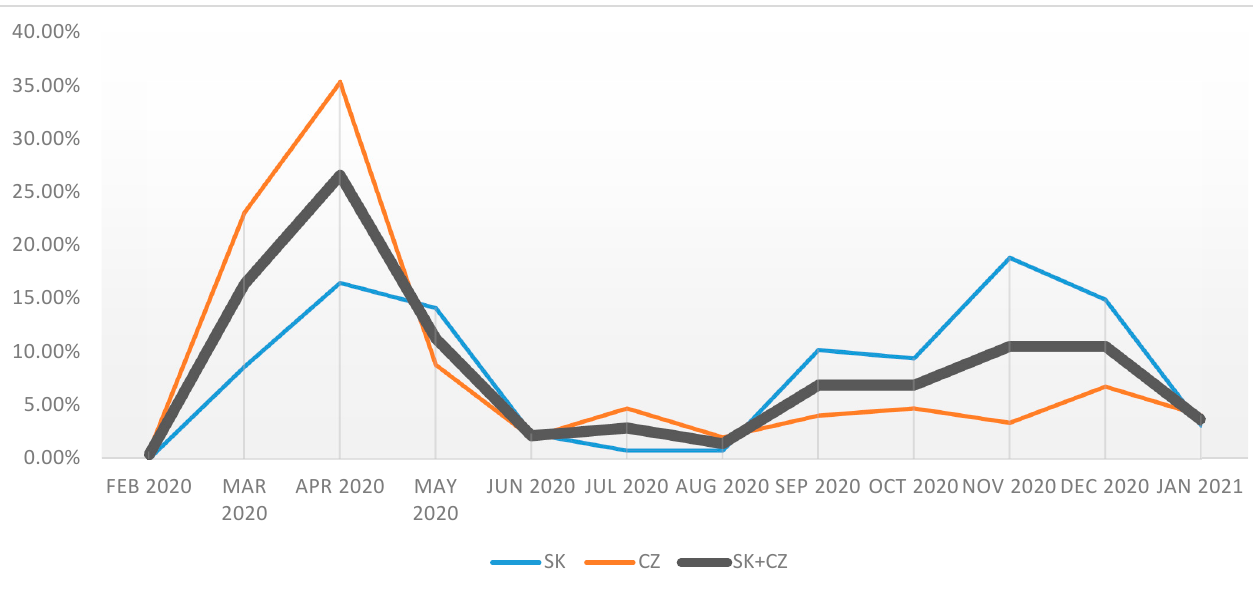
Figure 1. Chronology of published texts (percentage of total).